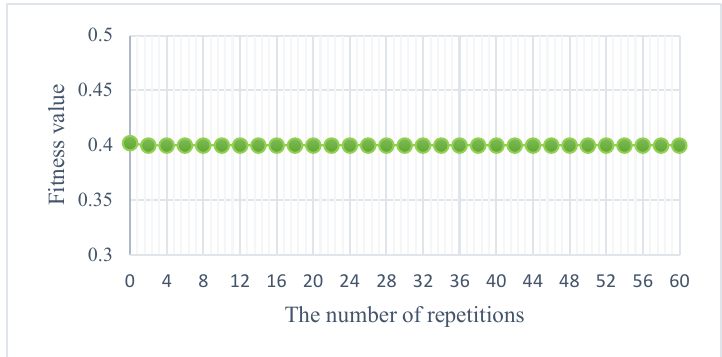
Figure 5. Stability diagram for repeating the proposed algorithm 60 times.